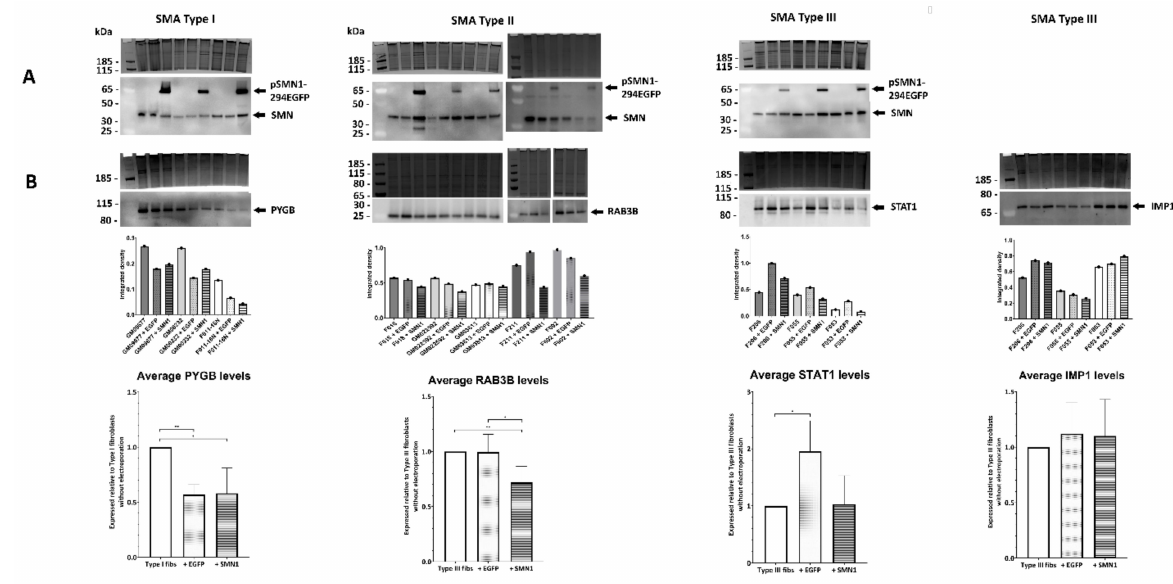
Figure 6. Protein expression changes following transient transfection of SMA Type I, II and III fibrob- lasts. ( A ) Representative Western blots confirming the presence of plasmids containing full-length human SMN1 (pSMN1-294EGFP) in cells transiently transfected using electroporation. ( B ) Represen- tative Western blots show levels of PYGB, RAB3B, STAT1 and IMP1 following electroporation of the SMA fibroblasts with plasmids containing (+SMN1) or without (+EGFP) SMN. Graphs below